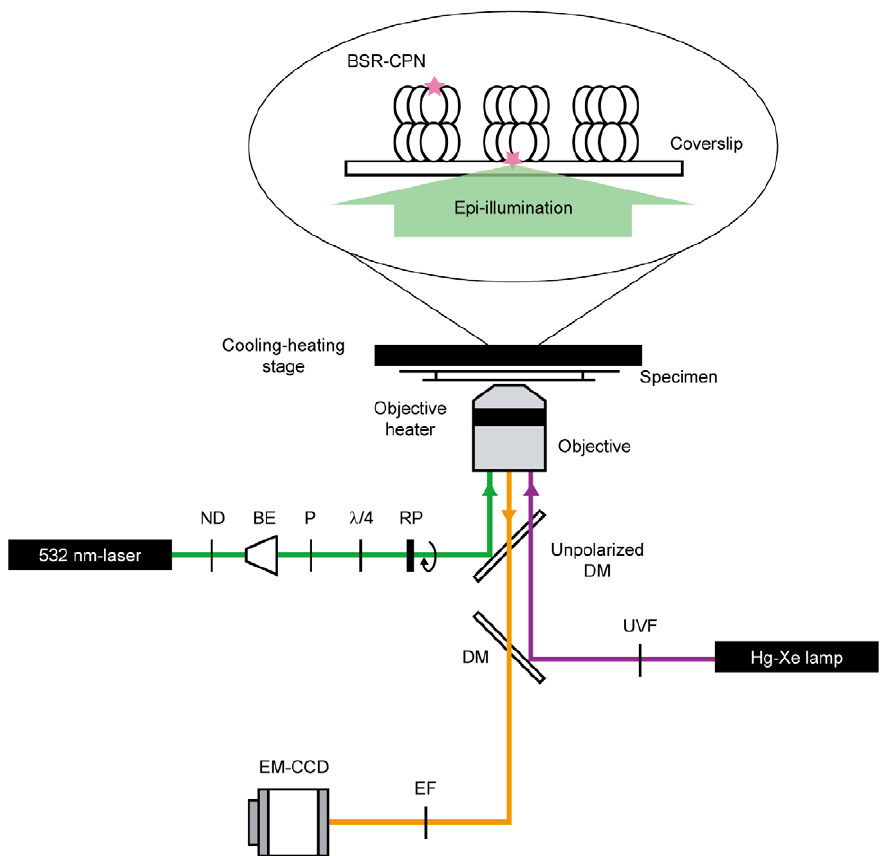
Figure 3. Schematic drawing of the microscopic system for modulating the excitation polarization. Optical paths for different wavelengths are distinguished by their colors. The polarization of excitation laser ( green ) was continuously modulated by a polarizer mounted on a motorized rotary holder. The polarizer was rotated at 20.01 u /s. Fluorescence ( orange ) was collected through an objective, and detected with an electron multiplying charge-coupled device camera. Caged ATP was photolyzed by UV light from a Hg–Xe lamp ( purple ). BSR-CPN was directly immobilized onto the surface. ND, neutral density filter; BE, beam expander; P, polarizer; l /4, quarter wave plate; RP, rotating polarizer; DM, dichroic mirror; EF, emission filter; UVF, UV sharp-cut filter. The figure in the ellipse connotes a specimen for microscopic observation. BSR ( pink star ) was excited using an epi-illumination configuration.